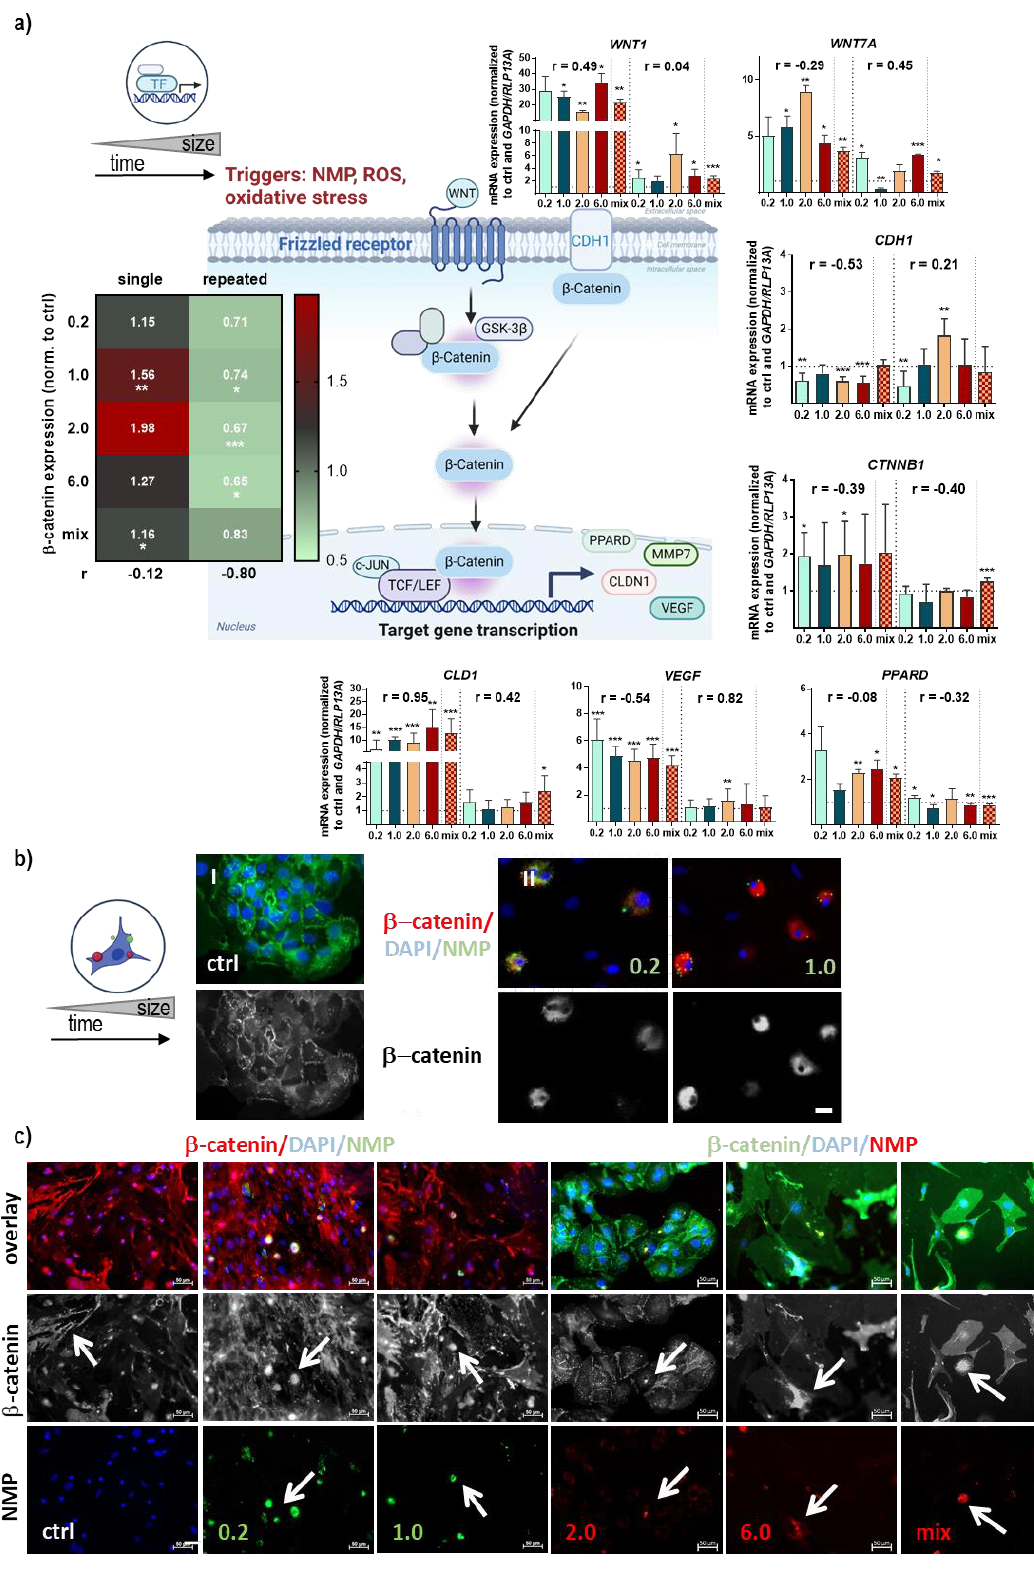
Figure 5. Effects on β -catenin pathway following NMP exposure in lung cells. ( a ) Study scheme and schematic representation of β -catenin signaling along with gene expression levels of WNT1/7A, CDH1, CTNNB1, CLD1, VEGF , and PPARD as measured by qPCR, and heatmap of β -catenin